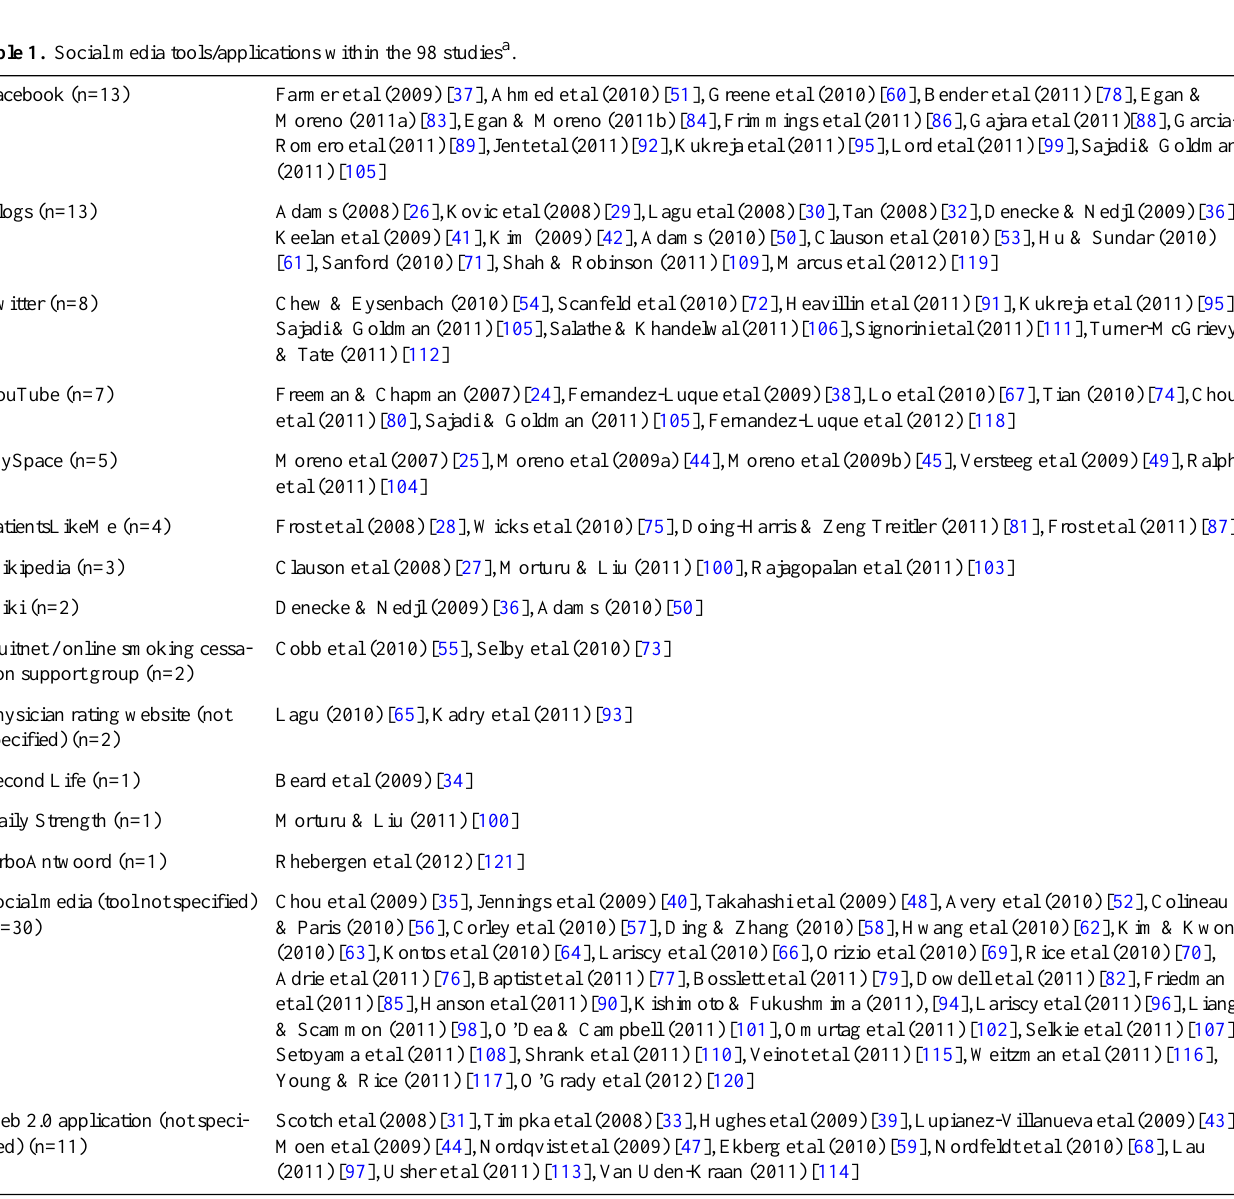
Table 1. Social media tools/applications within the 98 studies a